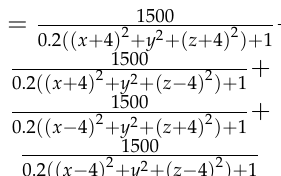
( d ) model 4 Figure 5. Diagram of reconstructed temperature fields by algebraic reconstruction technique (ART).